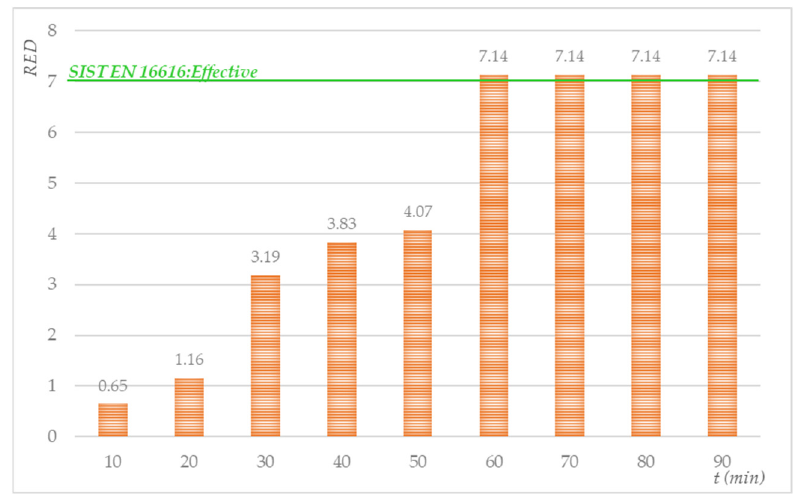
Figure 9. Antimicrobial efficiency of the injection of saturated steam into the drum of a laundering machine containing cotton swatches inoculated with S. aureus ( average N 0 = 2.56 × 10 7 CFU/mL).